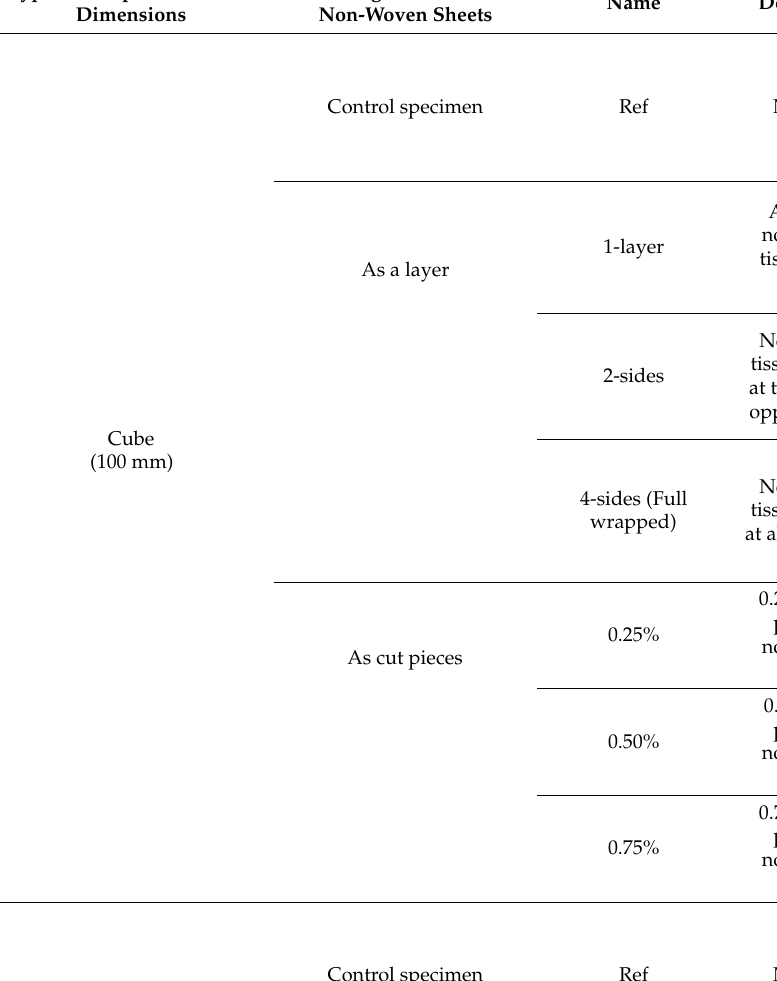
Table 5. Type of samples and exposed